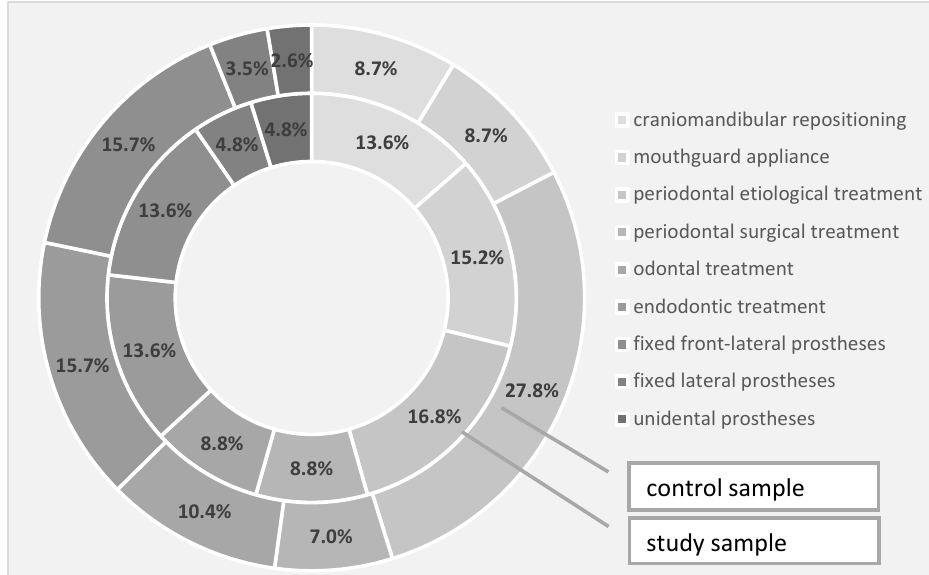
Figure 3. Treatment requirements identified in the investigated samples.